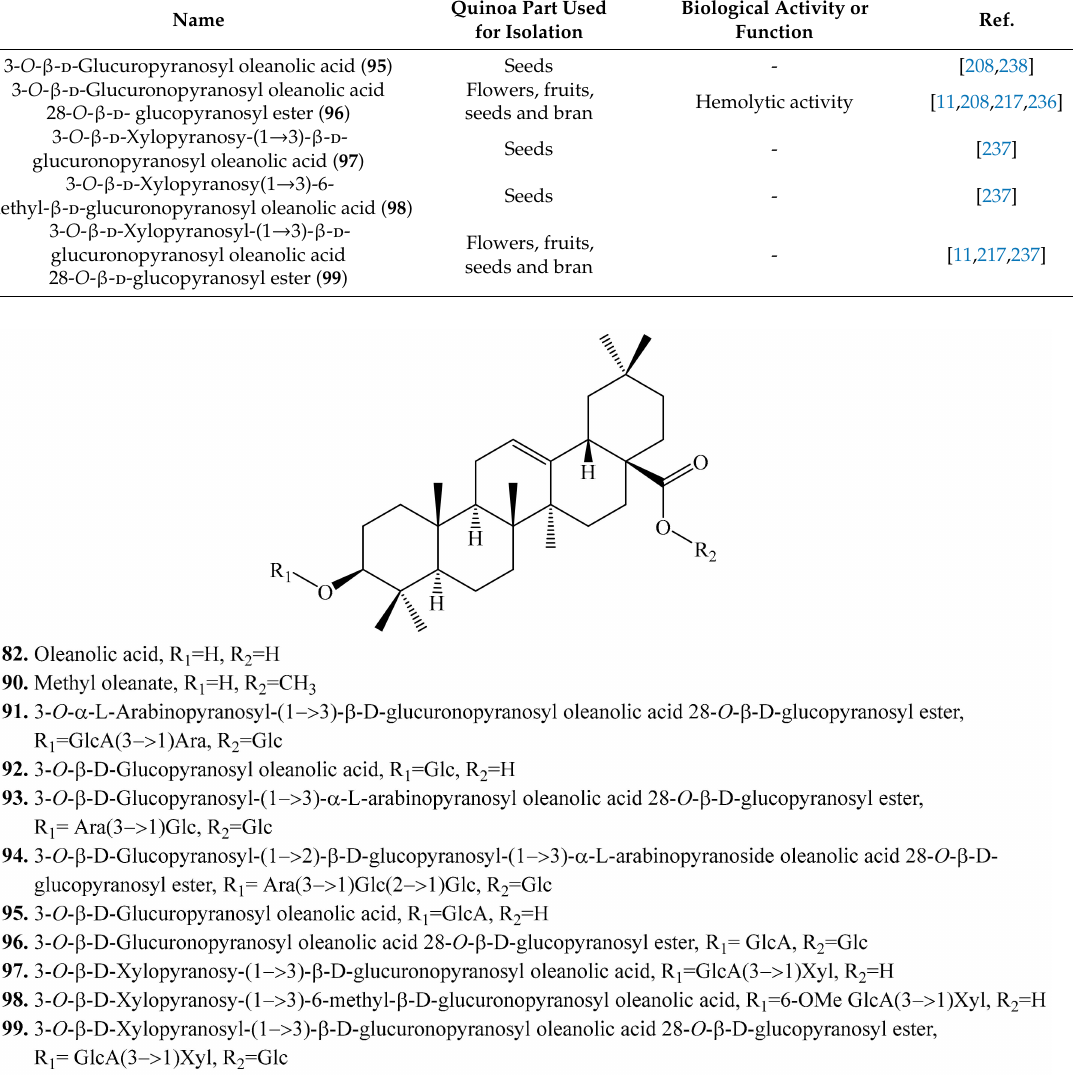
Figure 11. Structures of the oleanolic acid and its glycosides isolated from